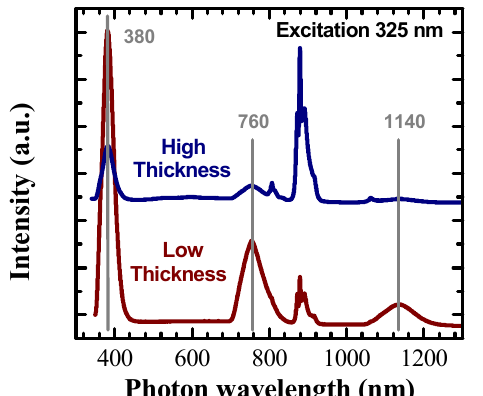
Figure 8. Comparison between the visible-range photoluminescence spectra of Nd-doped lanthanum niobate in both layer thickness sputtering conditions excited at 325 nm.